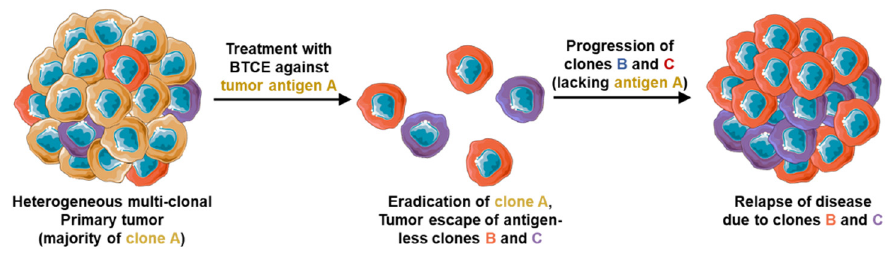
Figure 3. Mechanism of tumor escape and relapse after BTCE therapy targeting only one surface marker due to development of antigen-less clones.